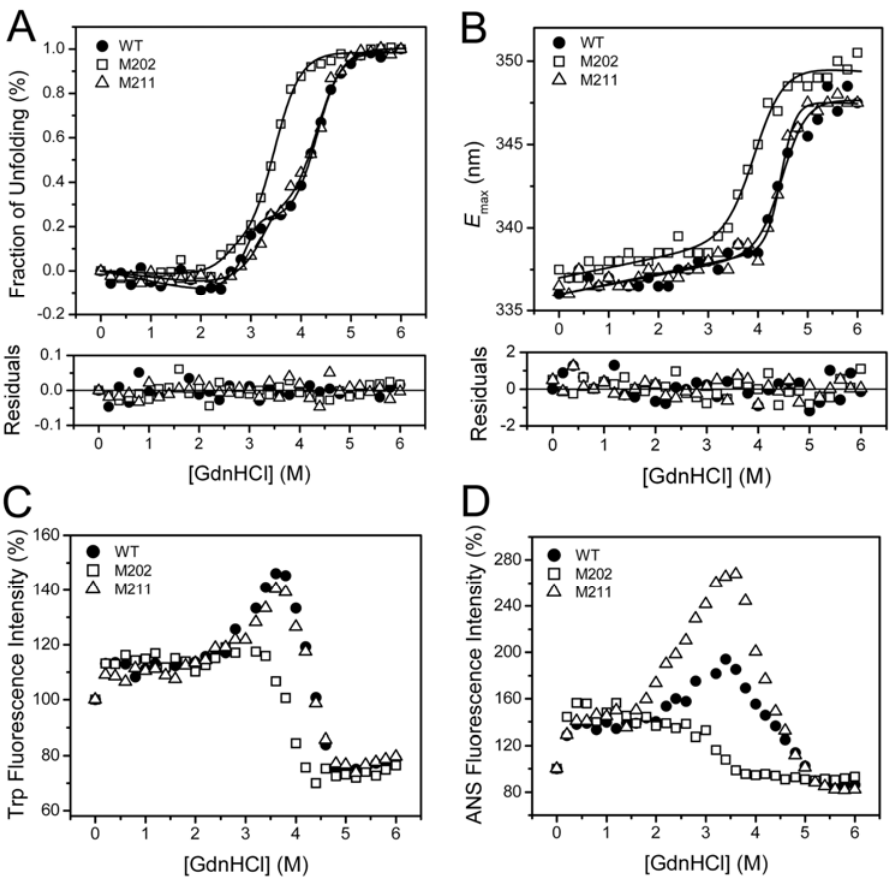
Figure 5. Unfolding of WT and mutants monitored by the ellipticity at 222 nm (A), emission maximum wavelength (B) and intensity (C) of the intrinsic fluorescence, and ANS fluorescence intensity at 470 nm (D). The data in panel A and B were fitted to a three-state transition and a two-state transition, respectively, using the equations listed in Materials and Methods. The CD data were normalized by ( F − F ellipticity at 222 nm, F and F are the ellipticity of the native and fully-denatured proteins, 0 1